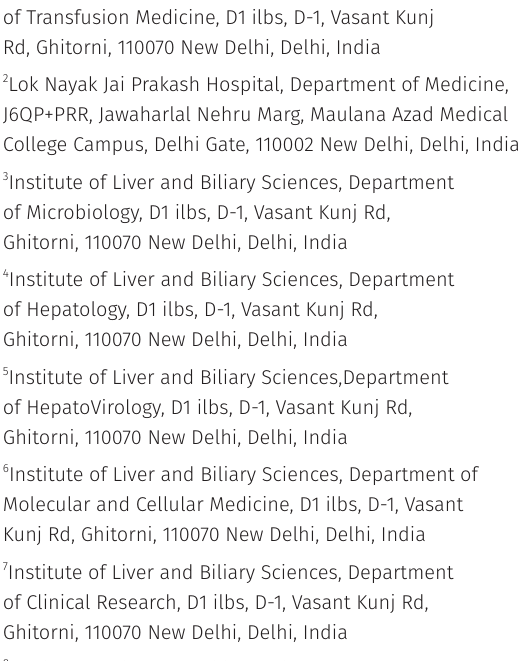
Figure S1. Reduction in viral load after transfusion (ct value). Table SI. Convalescent Plasma Donation Details (n=14). Table SII. Median baseline and post transfusion cytokine